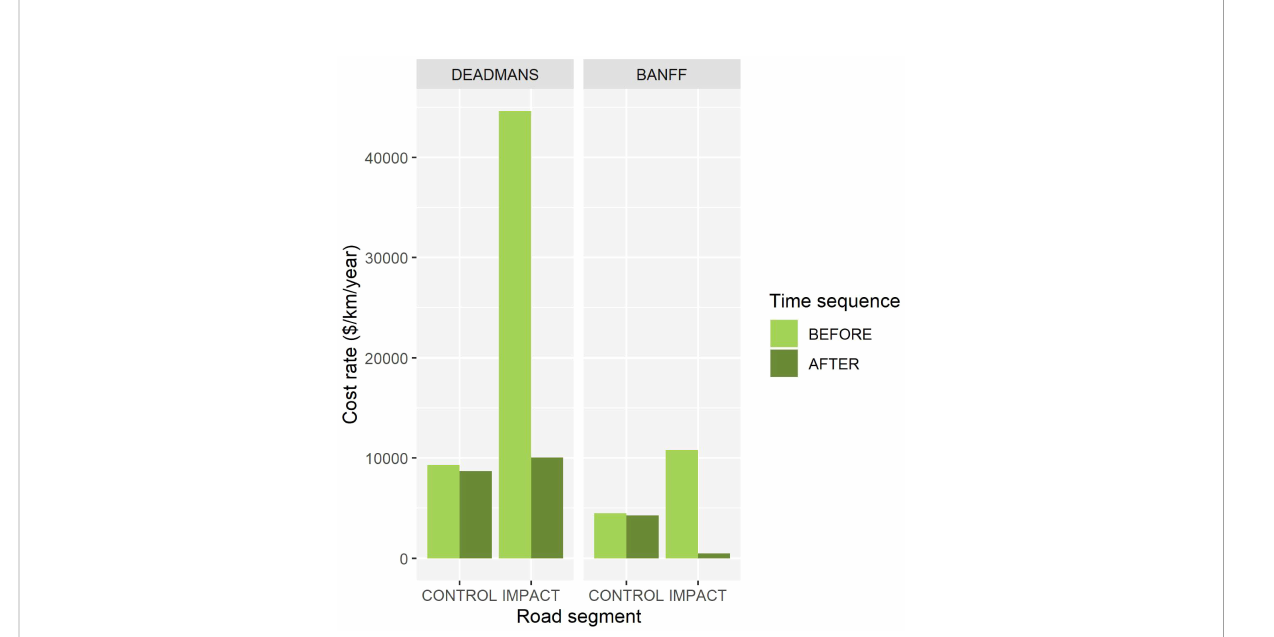
FIGURE 4 Estimated cost of collisions occurring within each road segment and time sequence for the two study areas, Dead Mans Flats and Banff National Park. Cost estimates per collision are based on Huijser et al